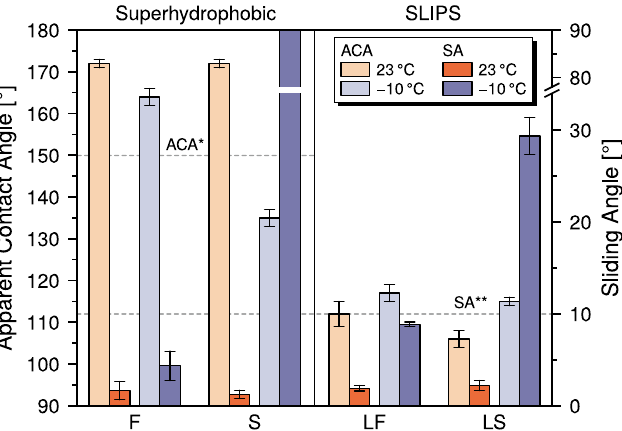
Figure 4. Apparent water contact angle (ACA) and water sliding angle (SA) measured on pristine samples at surface temperature 23 °C and − 10 °C. Error bars are equal to one standard deviation. ACA*: lower CA threshold for superhydrophobic behavior; SA**: upper SA threshold for superhydrophobic and slippery